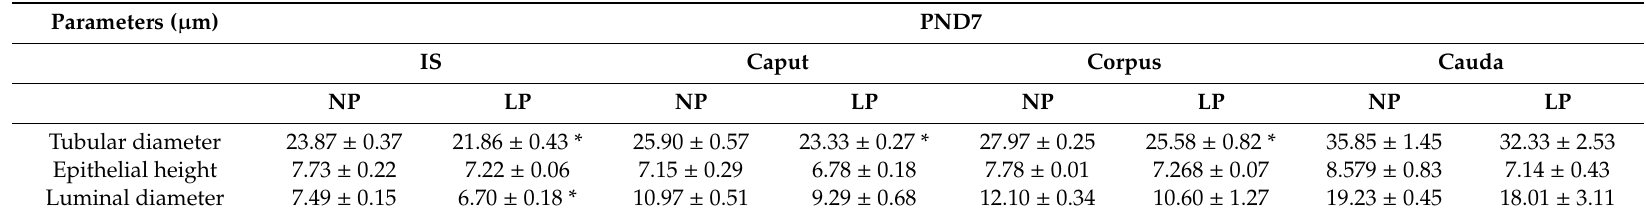
Table 2. Epididymal morphometry at PND7.